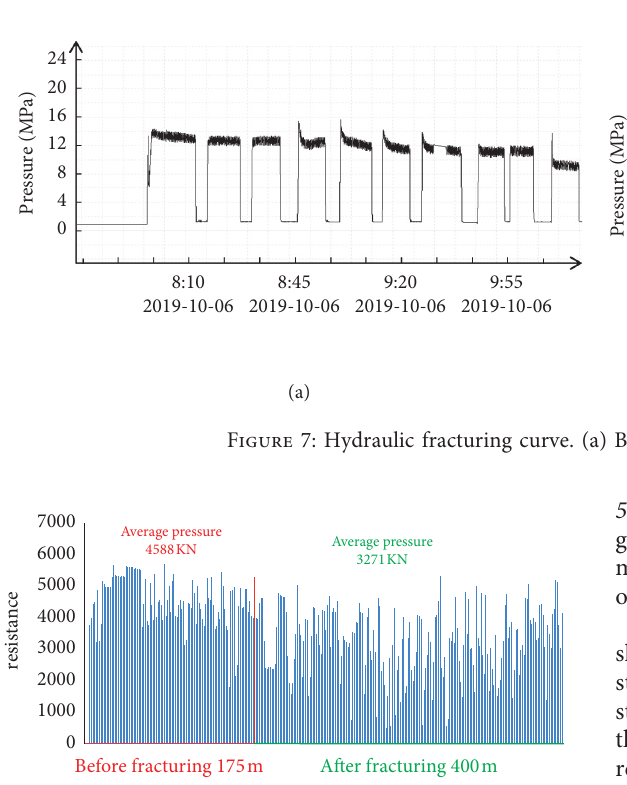
Figure 6: Drilling layout drawing. (a) Drilling layout. (b) I-I section.